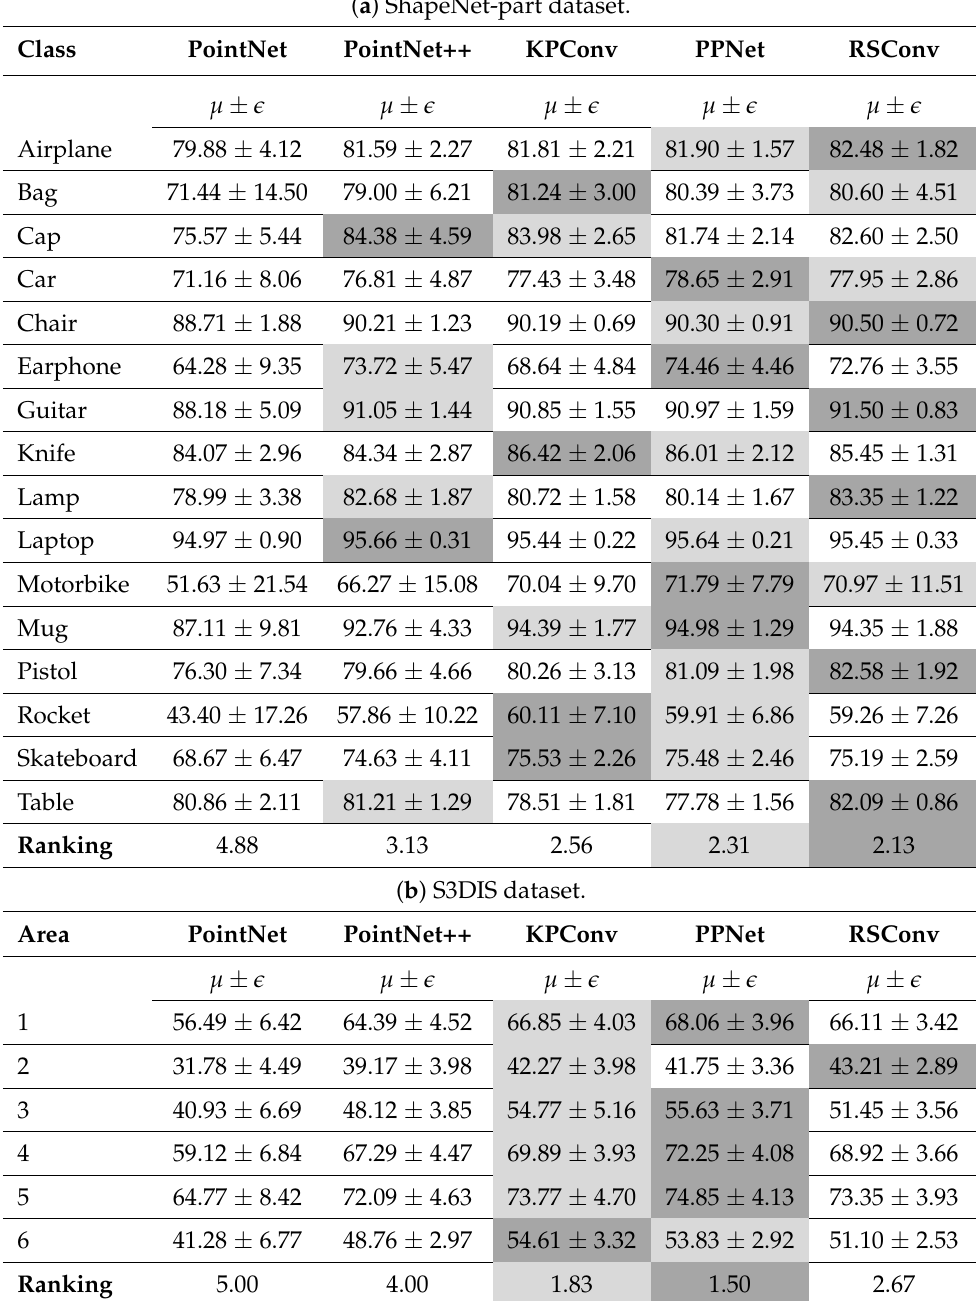
Table 7. Comparison of deep learning models in terms of mIoU per class in the whole learning procedure (averaged over 200 epochs). In table ( a ) we show the results in the ShapeNet-part dataset and in the table ( b ) we display the results in the S3DIS dataset. We use dark and light grey colors to denote the best and the second-best model. Please note that the last row of both tables, entitled " Ranking ", refers to the ranking mechanism described in Section 3.2.3. ( a ) ShapeNet-part